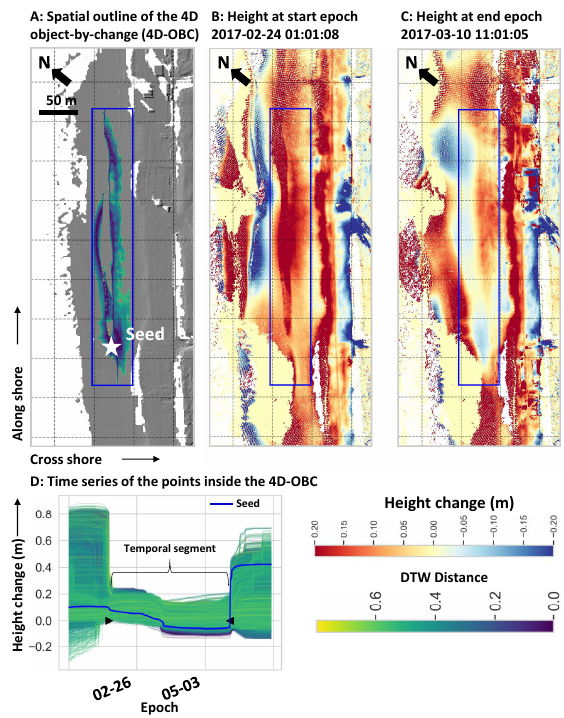
Figure 1. Study area (star in B). The point clouds sample the area visualized in A. The blue box represents the subset of the study area as shown in Figure 2. Data: Aerial imagery ©pdok.nl